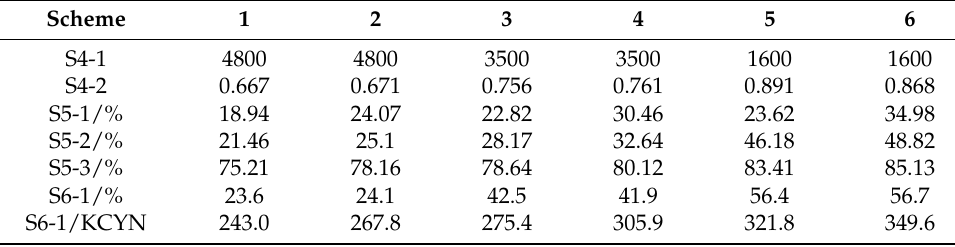
Table 4. Calculation results of market structure indicators under each